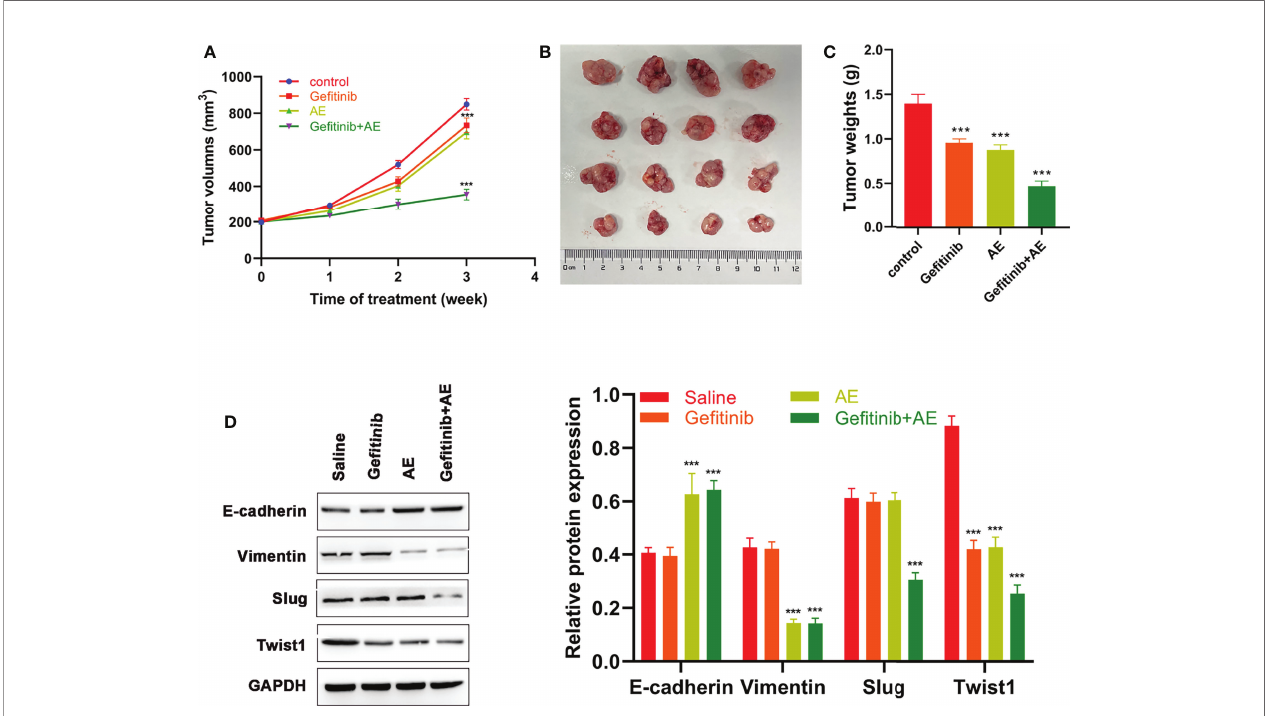
FIGURE 4 | AE Could Enhance the Sensitivity of Xenograft Tumors to Ge fi tinib. (A) Volumes of xenograft tumors, (B) tumor growth, (C) weights of xenograft tumors and (D) WB results of EMT-related proteins of different groups after different treatments.